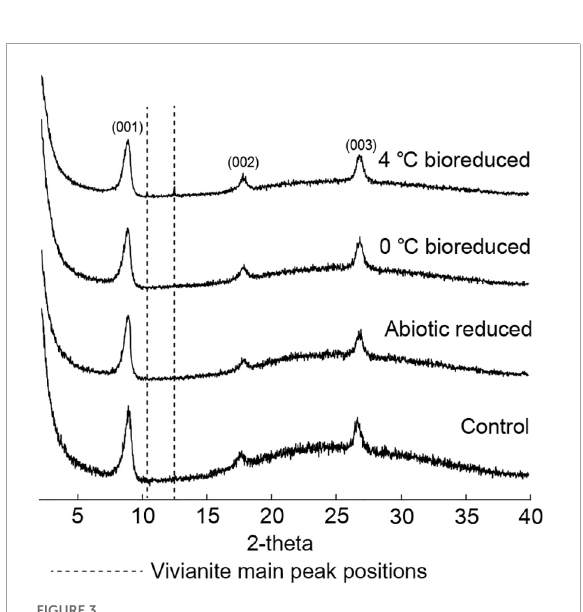
FIGURE3 X-ray diffraction (XRD) profiles for illite and vivianite main peaks for bioreduced, abiotic reduced, and control samples after 24 ◦